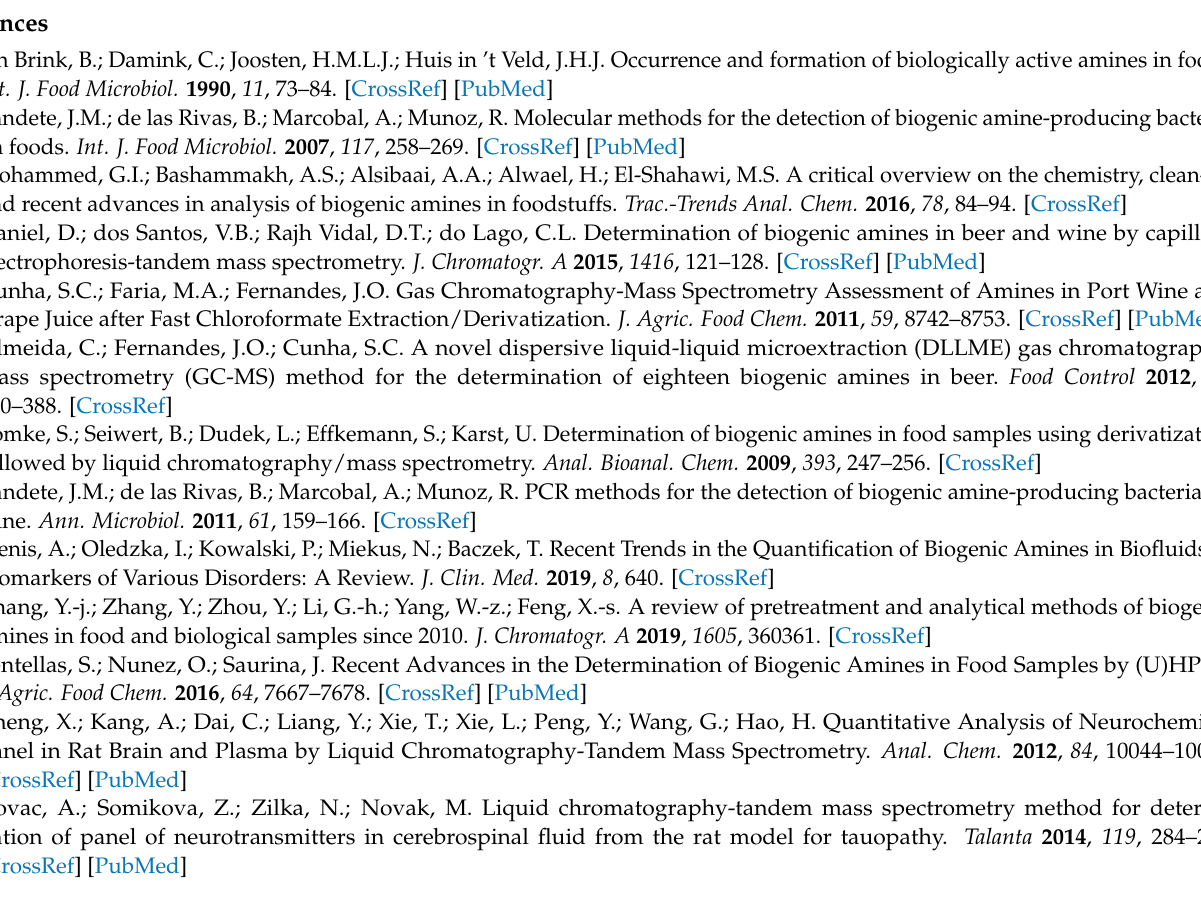
under different conditions (concentration of benzoyl chloride and vortex time) of derivatization; Figure S1. Chromatogram of 7 BAs derivatives in 1000 nM standards mixture. Results show that the chromatographic peak is obviously broadened or even trailing, when the flow rate was 0.2 mL/min (Figure S1A). Chromatography peak shapes were unsatisfactory, when the mobile phase A was water and phase B was acetonitrile (Figure S1B); Figure S2. Chromatogram of 14 derivatized BAs in spiked fish sample (1000 nM); Figure S3. Graphs of calibration curves with data points of 14 BAs derivatives; Figure S4. A flow chart for the steps of derivatization of standards; Figure S5. A flow chart for the steps of derivatization of fish